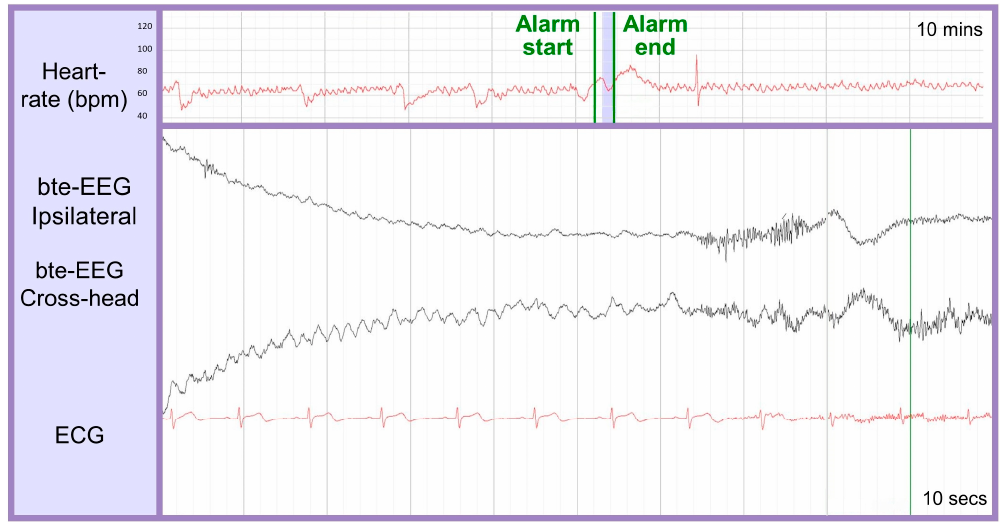
Figure 7. Example of a detected seizure segment correctly labeled by the readers on the bte-EEG experimental setup but mislabeled on the bte-EEG and ECG and heart rate setup (change from TP to FN). The top plot contains the heart rate data in red within a 10 min window, and the bottom contains the bte-EEG channels (in black) and ECG data (in red) within a 10 s window. The shaded section of the heart rate plot corresponds to the plotted area of the bottom one. The green vertical lines indicate the automated algorithm’s time events.